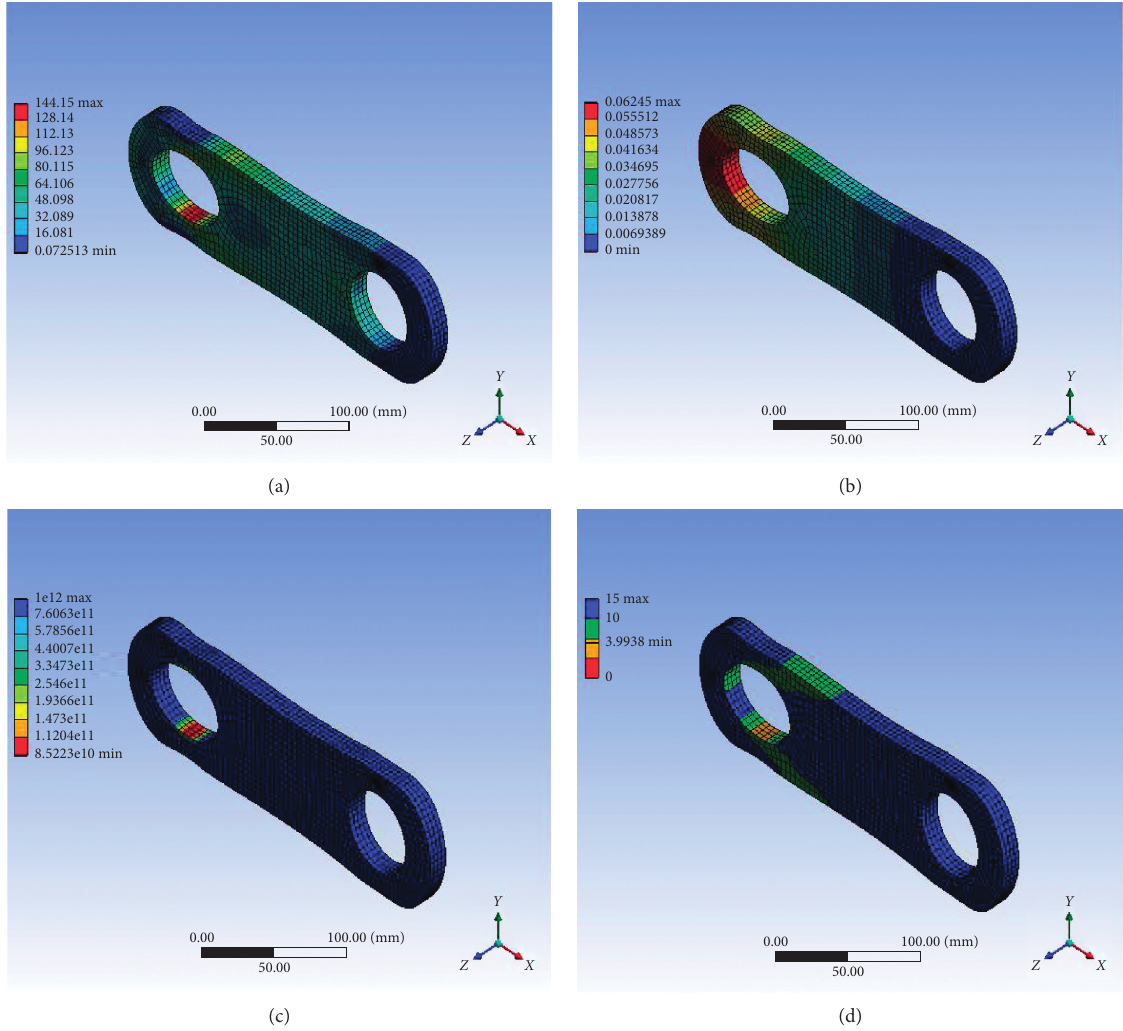
Figure 17: Simulation results for chain link with a modeled crack and neck radius 1245.5mm ( X � 4mm): (a) equivalent stress, (b) deformation, (c) fatigue life, and (d) safety